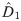
ABIDE data set: Distance contrast D^1 between the weighted ASD and control connectomes for a threshold T = 0.5.